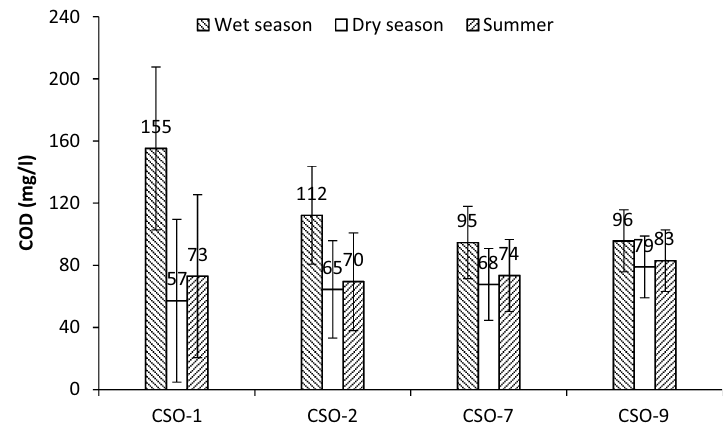
Fig. 4 Average concentra- tions of COD (mg/l) during (i) wet season (June to October, 4 samples), (ii) dry season (December to March, 4 sam- ples), and (iii) summer (April to May, 2 samples) at the 9 sam- pling locations located close to